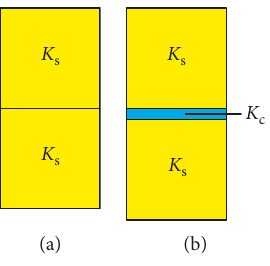
Figure 4: Schematic of (a) two solid elements in series and (b) two solid elements and one cohesive element in series.